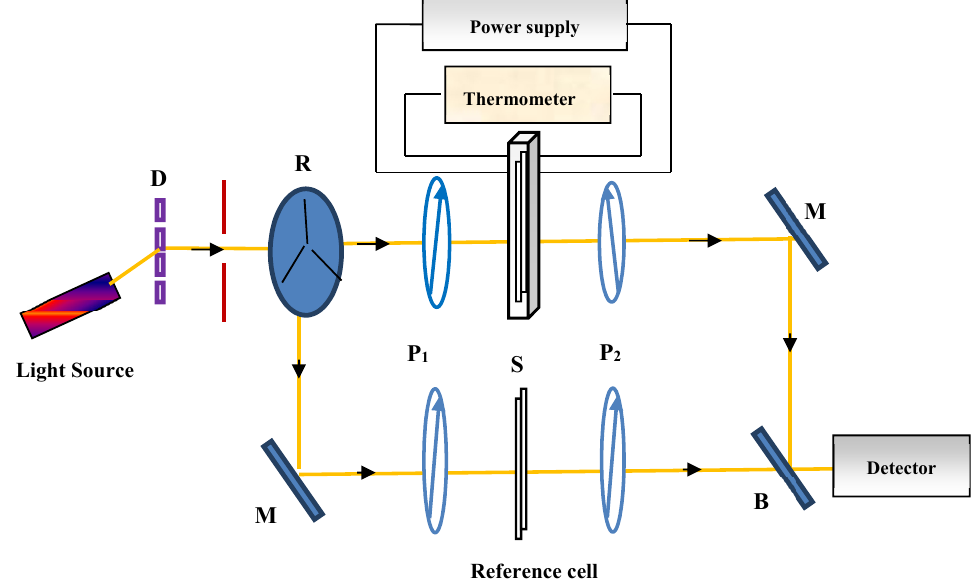
Figure 12. Optical set-up of the modified spectrophotometer (MS) technique for measuring the transmittance and phase transition of LC samples, with diffraction grating (D); rotating disk (R); mirror (M); beam splitter (B); two polarizers (P 1 and P 2 ); and the sample (S) inside electric oven.